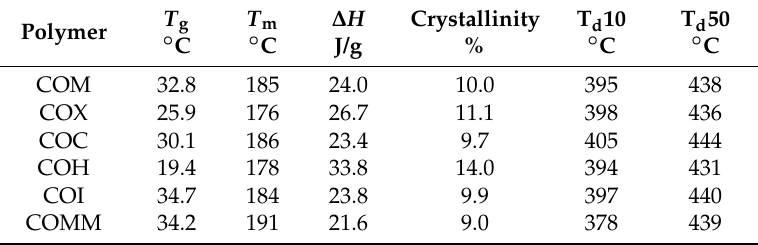
Figure 4. DSC for PA6 containing cyclic compounds. Table 2. Thermal properties of PA6 containing cyclic compounds.